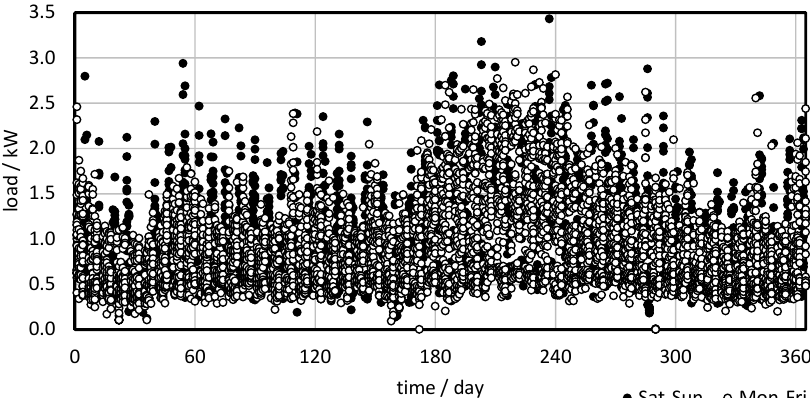
Figure 3. Seasonal variation in the measured load.